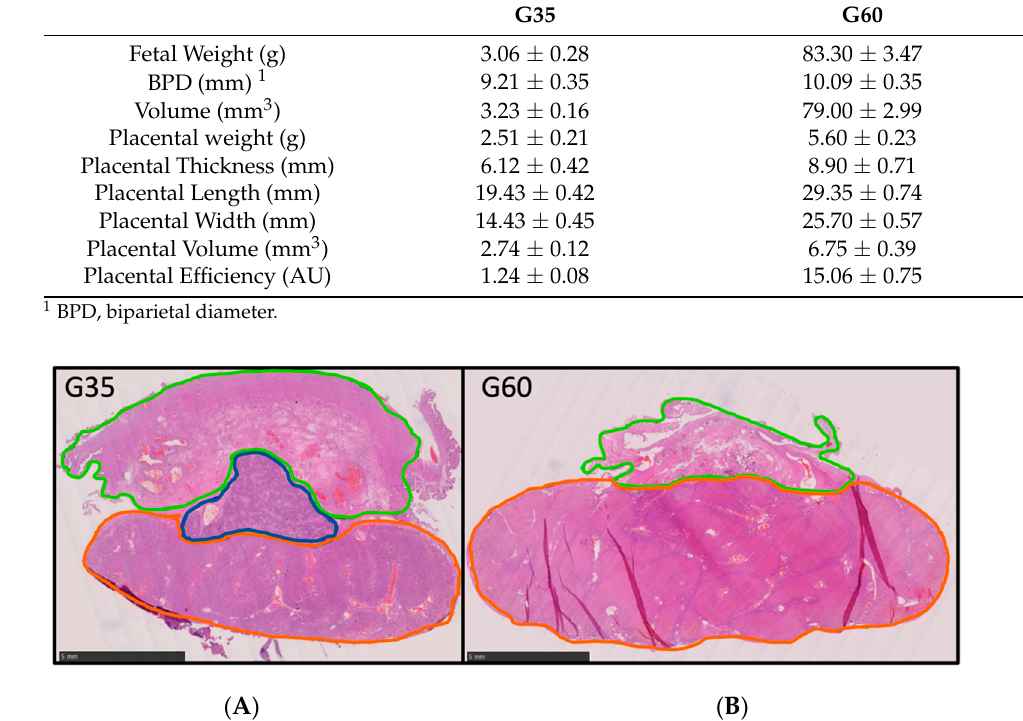
Figure 4. Placental structure at G35 and G60. Placental structure at ( A ) gestational day 35 and ( B ) gestational day 60. Green line = decidua. Dark-blue line = subplacenta. Orange line = interlobium and labyrinth zone. Scale = 5 mm.